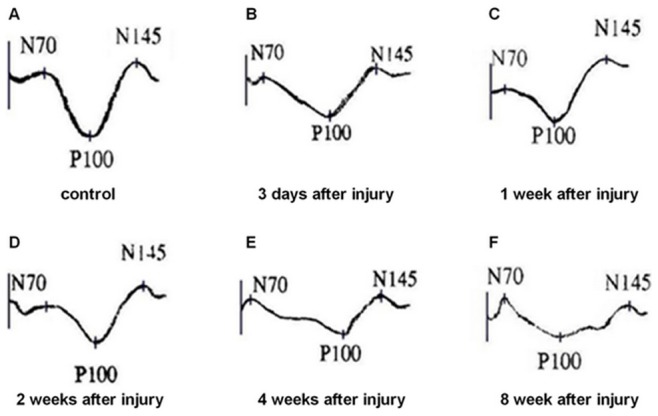
The N70-P100-N145 wave of P-VEP.(A) The latency of the N70-P100-N145 wave was short and the electric potential amplitude was steep in the control eyes. (B–F) The N70-P100-N145 wave became delayed and decreased after semi-transection of the optic nerve.